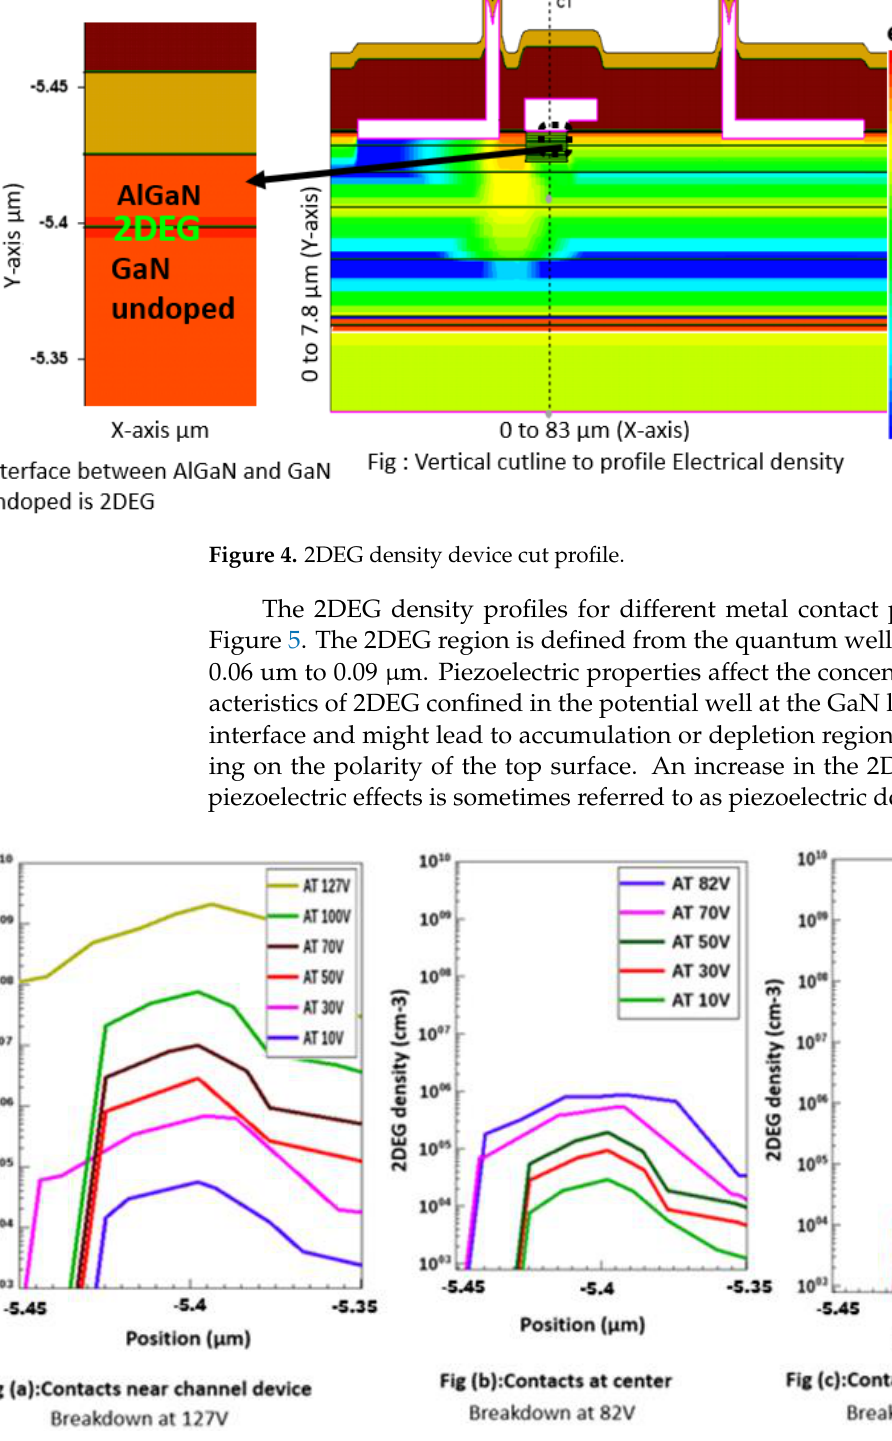
Figure 5. 2DEG density vs. applied voltages with different metal contact positions.